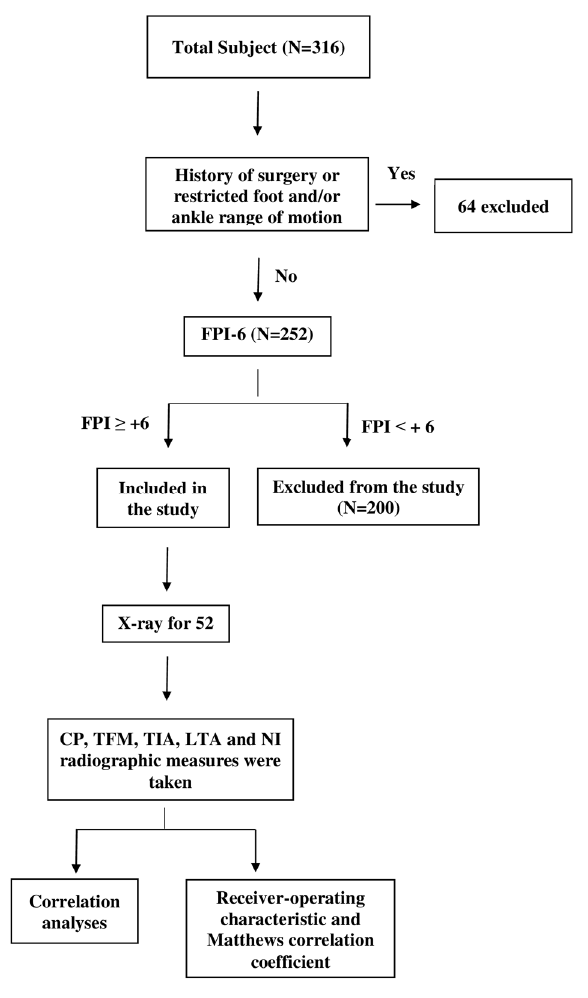
Figure 1. Flowchart of the study selection procedure and design.